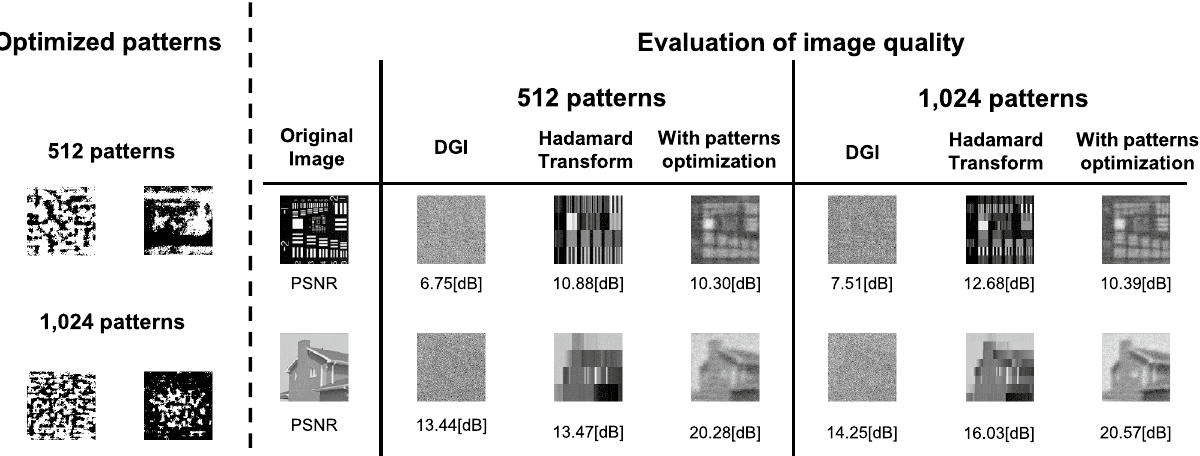
Figure 9. Comparison between the pattern optimization and conventional methods: An example of an optimized pattern is shown on the left side of the figure. The right side of the figure shows a comparison of reconstructed image quality. Image quality was compared with DGI 23 and Hadamard transform 22 implemented in an FPGA in previous studies. The size of the images was 128 × 128 pixels. The number of the encoding mask patterns were 512 and 1,024,